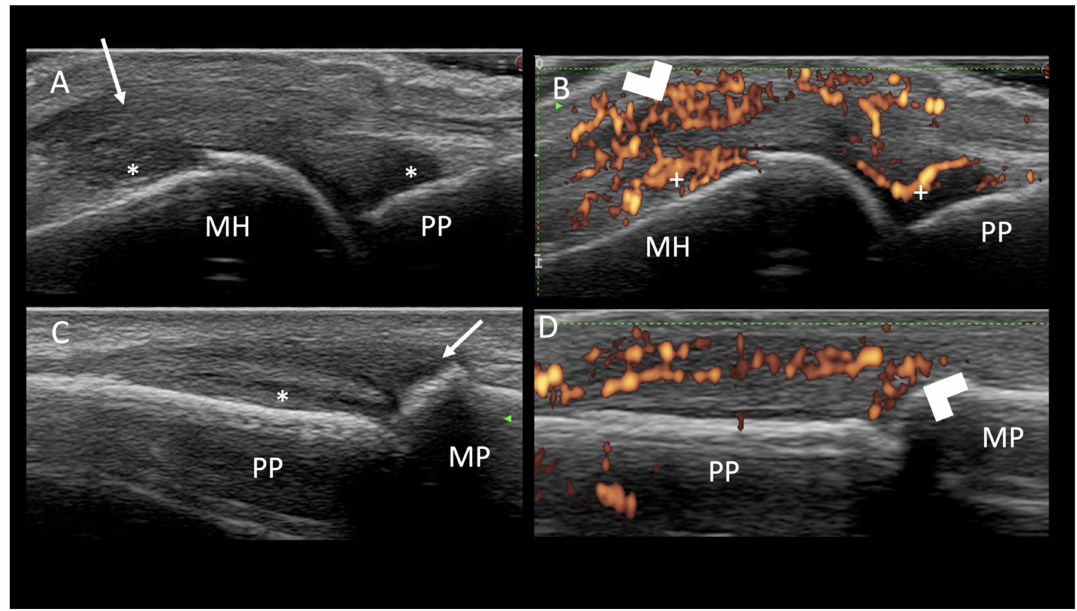
Figure 1. Longitudinal views of the metacarpophalangeal ( A , B ) and proximal interphalangeal joints ( C , D ) on ultrasound. ( A ) Synovial proliferation ( ∗ ) within the metacarpophalangeal joint and thickening, hypoechogenicity, and loss of fibrillary echotexture of the extensor tendon (arrow). ( B ) Intratendineous power Doppler signals (arrow head) in addition to the intrasynovial Doppler signals within the metacarpophalangeal joint ( + ). ( C ) Synovial proliferation of the proximal interphalangeal joint ( ∗ ) and thickening, hypoechogenicity, and loss of fibrillary echotexture of the extensor tendon insertion into the basis of the middle phalanx- enthesitis (arrow). ( D ) Entheseal power Doppler signals (arrow